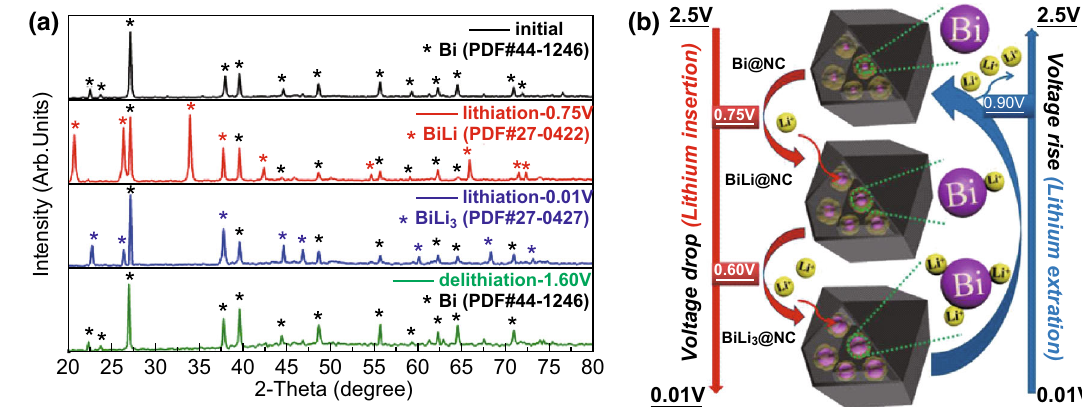
Fig. 8 XRD patterns revealing a structural and chemical evolution and b corresponding mechanism of the Bi@NC